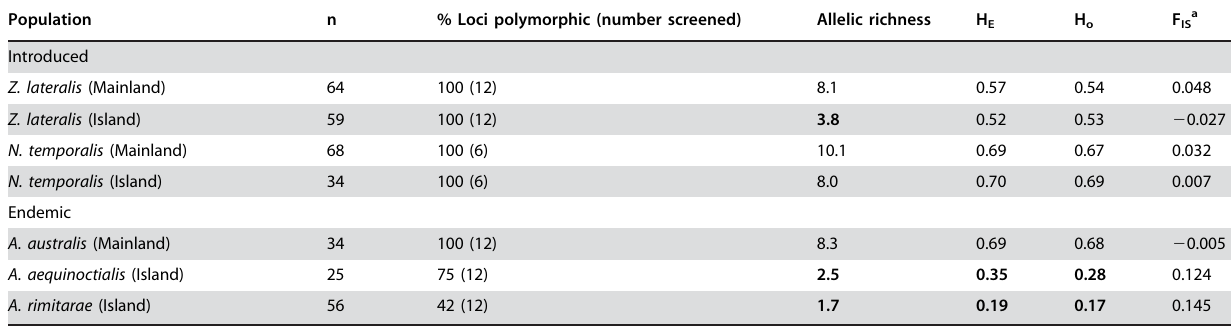
Table 1. Genetic diversity indices for introduced and endemic island taxa compared to their mainland counterpart. .. ... .... ... ... .... ... ... .... ... ... .... ... ... .... ... ... .... ... ... .... ... ... .... ... ... .... ... ... .... ... ... .... ... ... .... ... ... .... ... ... .... ... ... . Population n % Loci polymorphic (number screened) Allelic richness H E H o F ISa